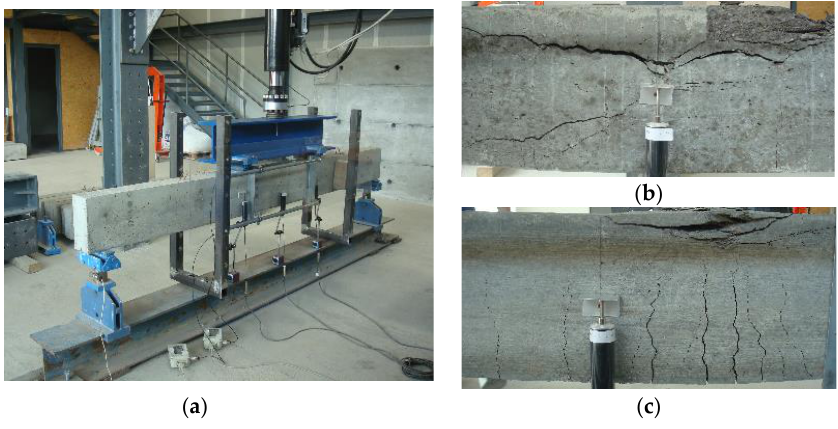
Figure 1. ( a ) Test setup and instrumentation; ( b ) Brittle failure; ( c ) Ductile failure.